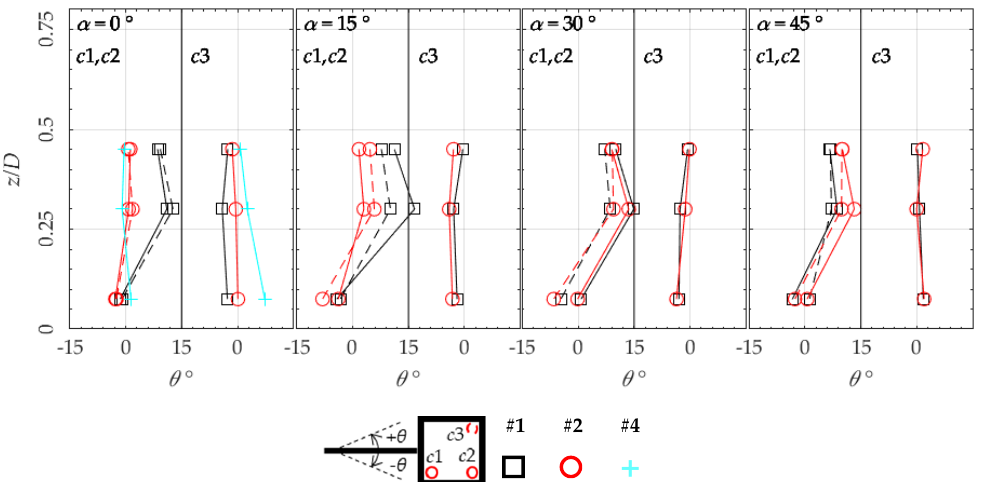
Figure 9. Mean skew angle at windward ( c 1, c 2) and leeward ( c 3) corner locations. Symbols as indicated in the legend, for configurations #1, #2, and #4 and the four wind directions. Positive values for nose-up skew direction.